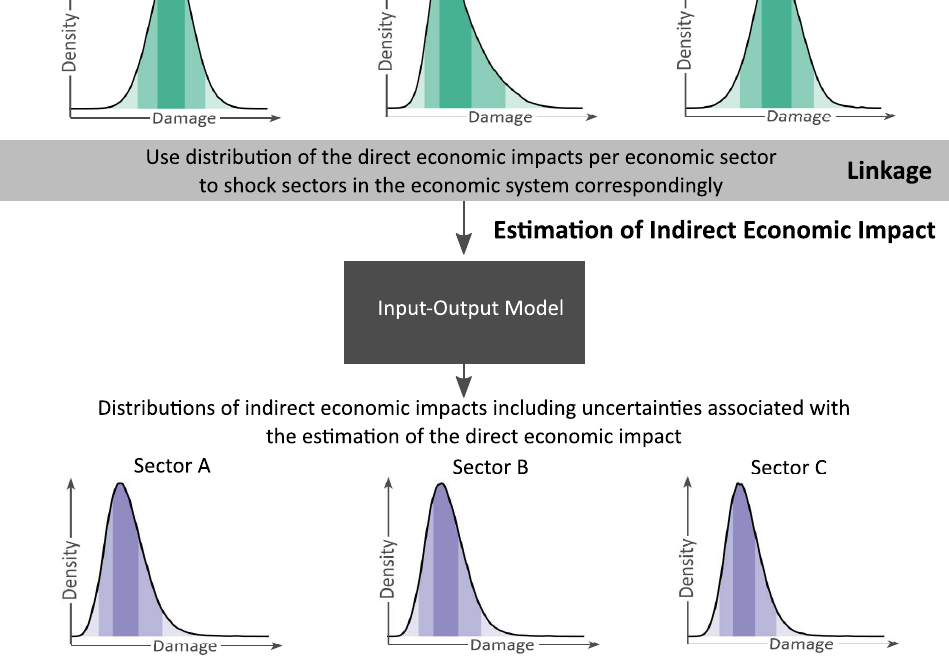
Fig 1. Modeling procedure and data sets (darker colours) used to derive inputs (brighter colours) for the hazard (blue), exposure (red) and vulnerability (orange) used by the method for the computation of the direct (green) and indirect (purple) economic